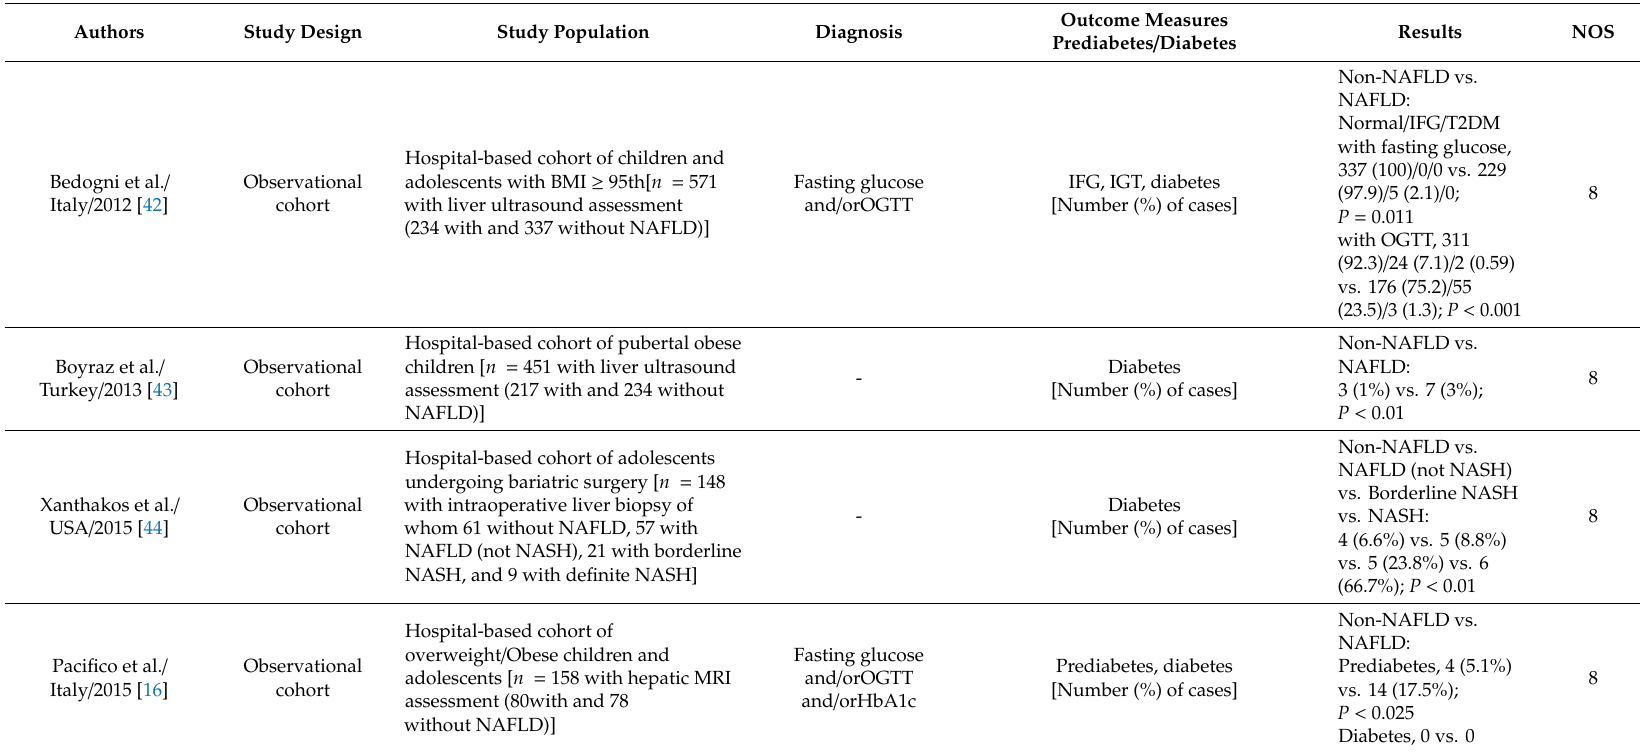
Table 3. Study characteristics for nonalcoholic fatty liver disease and type 2